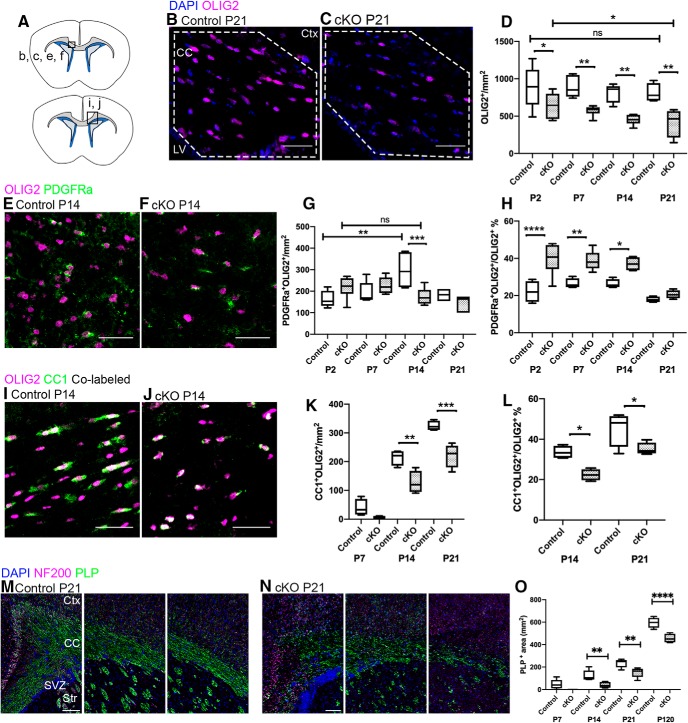
Raldh2 cKO results in reduced numbers of OPCs and OLs. A, Coronal section illustrating the regions imaged in B, C, E, F, and M, N (top) and I, J (bottom). B, Control mice have abundant OL lineage cells (OLIG2, magenta; CC, dotted line) and OLIG2+ cell numbers remain stable throughout the first three weeks of postnatal life. C, cKO mice have significantly fewer OLIG2+ cells at all time points examined. D, Quantification of OLIG2+ cell number in control versus cKO mice at each time point. E, F, Control and cKO mice both have OPCs [co-labeled by PDGFRα (green) and OLIG2 (magenta)]. G, control and cKO mice have comparable total PDGFRα+OLIG2+ cell numbers at all time points except P14, when cKO mice have fewer, and while controls displayed at least a two-fold increase in OPCs between P2 and P14, the pool of OPCs in cKO mice did not expand over the same time period. H, More OLIG2+ cells are co-labeled with PDGFRα in cKO mice than controls. I, J, Control and cKO mice both have mature OLs [co-labeled by CC1 (green) and OLIG2 (magenta)]. K, cKO mice have reduced CC1+OLIG2+ cell numbers at P14 and P21. L, In cKO mice, fewer OLIG2+ cells are co-labeled with CC1 than in controls. M, N, Control mice have more PLP+ labeled area (green) than cKO mice at P14, P21, and P120; NF200 (magenta) labels axons. O, Quantification of reduced PLP labeling. CC, corpus callosum; Ctx, cortex; LV, lateral ventricle; SVZ, subventricular zone; Str, striatum; cKO, conditional knock-out. Scale bars: 100 μm (M, N) and 50 μm (B, C, E, F, I, J). Box and whisker plot, box: 25th and 75th percentile, whiskers: minimum to maximum value, line at median. Floating bar plot, box: minimum to maximum value, line at median. *p < 0.05, **p < 0.01, ***p < 0.001, ****p < 0.0001. ns = not significant.